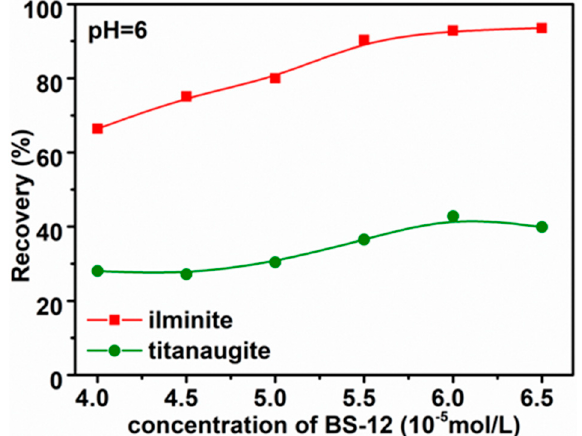
Figure 4. Flotation recovery rates of ilmenite and titanaugite as a function of BS-12 concentration at pH 6.